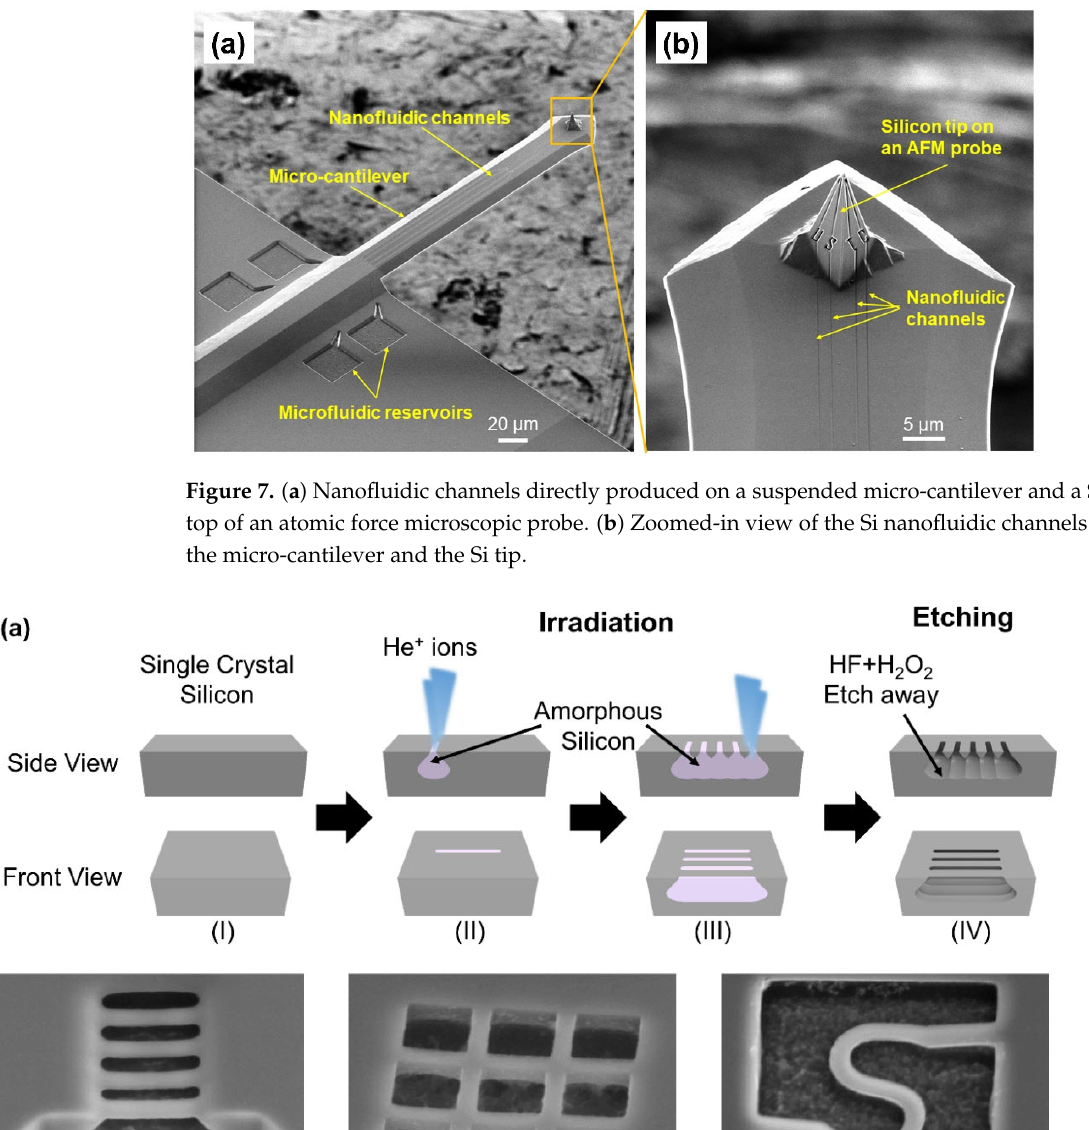
8 of 13 Figure 6. ( a ) Photograph of the fabricated micro ‐ nanofluidic channel device. ( b ) 3D cartoon image illustrating the micro ‐ nanofluidic device. ( c , d ) Bright ‐ field optical microscopic photographs of the micro ‐ nanofluidic channels. ( e ) Fluorescence microscopic image showing the fluorescence flowing from the left ‐ side microchannel to the right ‐ side microchannel through the nanofluidic channels, confirming the functionality. ( f ) SEM image of a customized nanofluidic channel with the USTC logo shape. ( g ) SEM image of a linear nanofluidic channel.